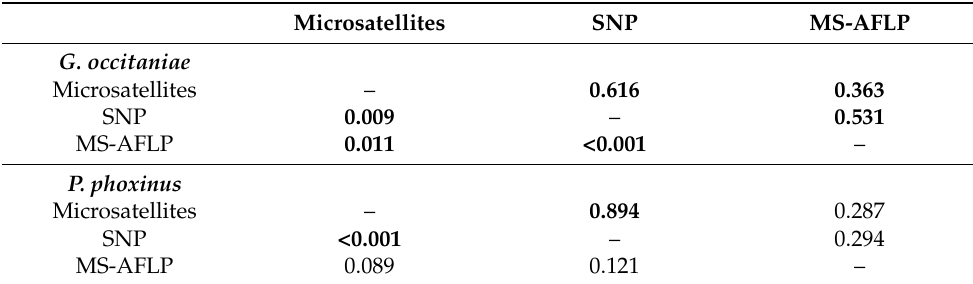
Figure 2. Biplots illustrating the relationships between pairwise genetic (based on SNP markers) and epigenetic differ- entiation (based on MS-AFLP markers) in ( a ) G. occitaniae (the red line indicates a significant relationship based on a simple Mantel test) and ( b ) P. phoxinus (no significant relationship was detected based on a simple Mantel test). Each dot represents a pairwise distance between two sites. The dashed line indicates the 1:1 line. Similar trends were observed with microsatellite markers but are not shown here. Table 3. Summary of simple Mantel tests testing the relationships between genetic and epigenetic differentiation between pairs of populations in G. occitaniae and P. Phoxinus . Results are presented for both genetic (microsatellites and SNPs) and epigenetic (MS-AFLP) markers. Mantel statistics are presented (above diagonal), as well as the associated p -values based on 1000 permutations (below diagonal). Significant relationships are bolded.